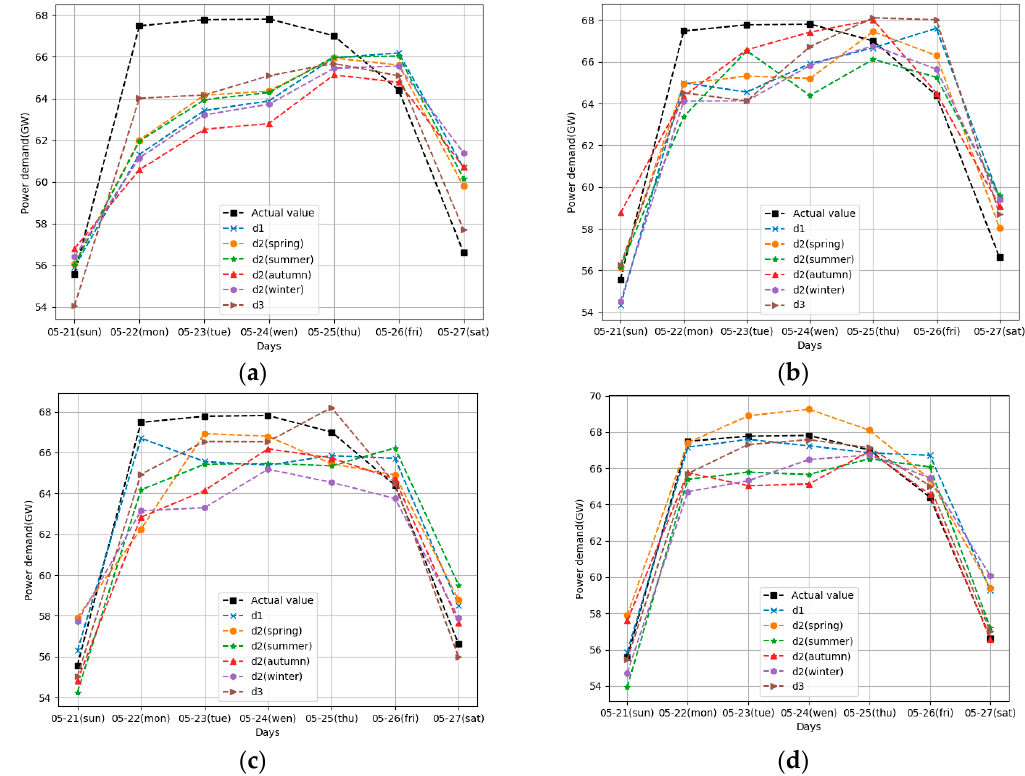
Figure 12. Experimental results by dataset for each model: ( a ) ARIMA; ( b ) ( c , l )-LSTM; ( c ) S2S LSTM; ( d ) ( c , l )-LSTM+CNN.